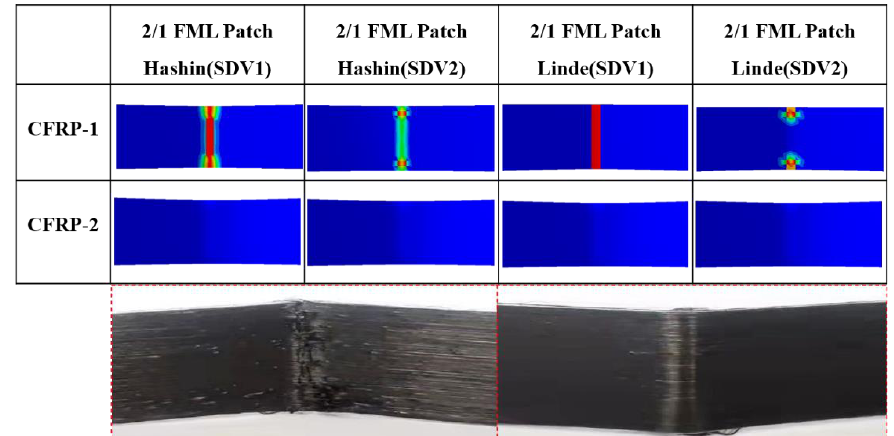
Figure 10. Damage of each CFRP layer in 2/1 FMLs patch.